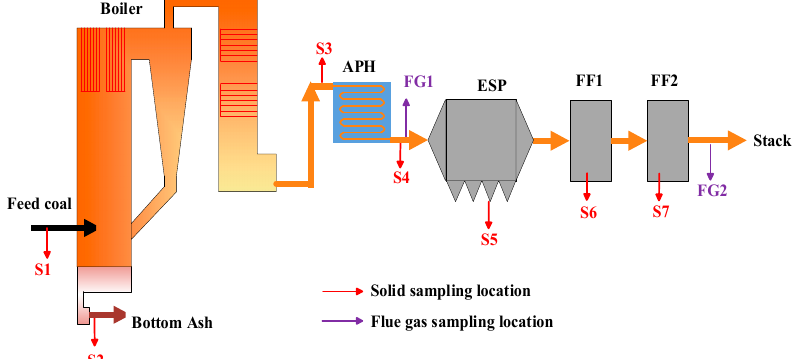
Figure 1. Schematic diagram of CFB boiler unit and sampling locations.